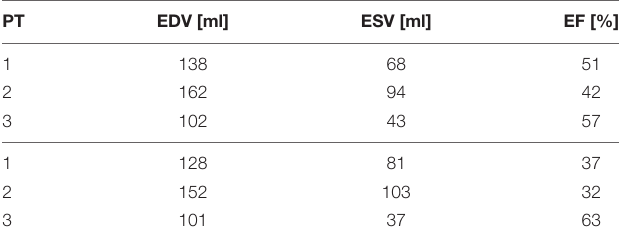
FIGURE 5 | Evolution of the reconstructed volume of the LV cavity. Circled points: instants of the MRI segmentation; solid line: spline interpolation on all the times of the simulation. TABLE 2 | End-diastolic volume (EDV), end-systolic volume (ESV), and ejection fraction (EF) as reconstructed from the computational procedure (above) and from clinical estimations